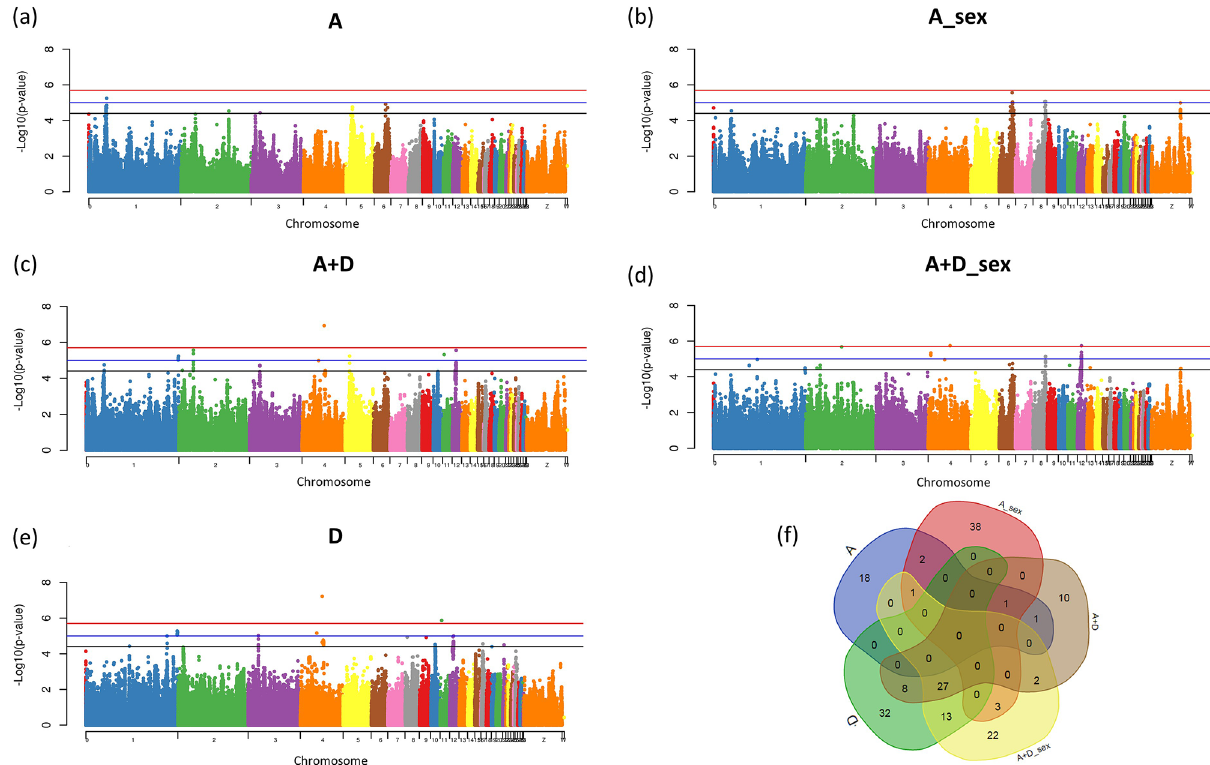
Figure 4. Manhattan plots of genome-wide association study for feed conversion ratio (FCR). The Manhattan plot indicates the -log10 (p-values) for genome-wide SNPs (y-axis) plotted against their respective positions on each chromosome (x-axis). The horizontal red, blue and black lines indicate the 5% genome-wide significant (4 × 10 –6 ), moderate (1 × 10 –5 ) and suggestive (4 × 10 –5 ) thresholds, respectively. The Manhattan plots are presented fitting five different SNP effects in the model: ( a ) additive effect (A); ( b ) additive fit in each sex (A_sex); ( c ) additive plus dominance (A + D); ( d ) additive plus dominance fit in each sex (A + D_sex); ( e ) dominance (D). The ( f ) is a Venn diagram summarizing the number of significant SNPs identified when each different SNP effect was fit in the model. The Venn diagram was constructed using a Bioinformatics and Evolutionary Genomics tool available in http://bioin forma tics.psb.ugent .be/webto